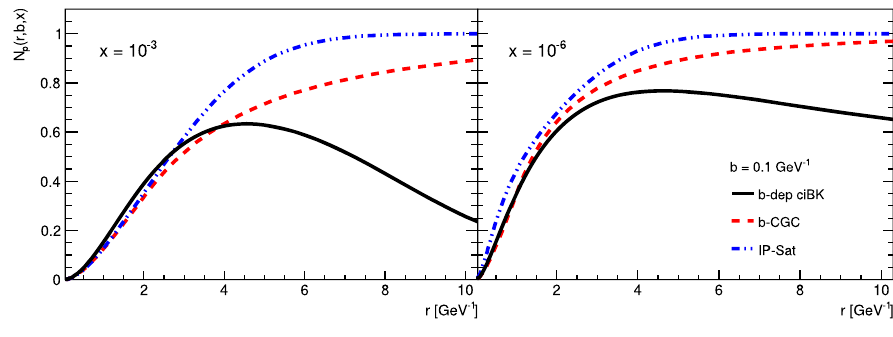
Fig. 3 Dipole-proton scattering amplitude for a fixed impact parameter ( b = 0 . 1 GeV − 1 ) and two values of